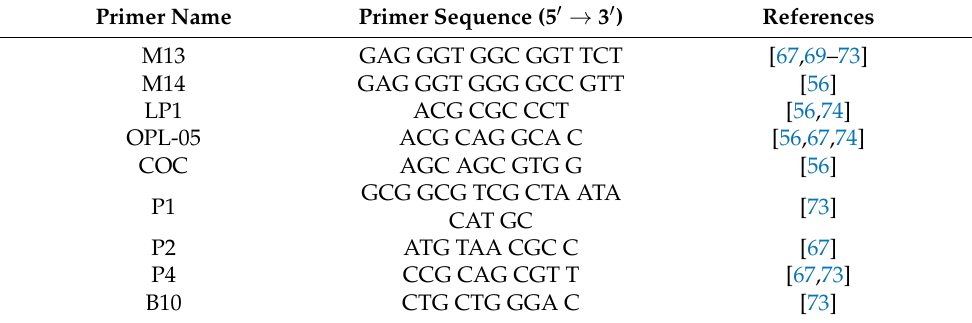
Table 2. Primers used for L. plantarum RAPD